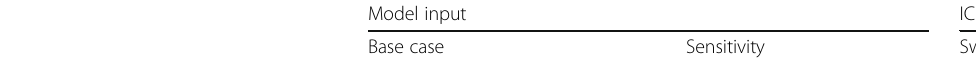
Table 8 Sensitivity